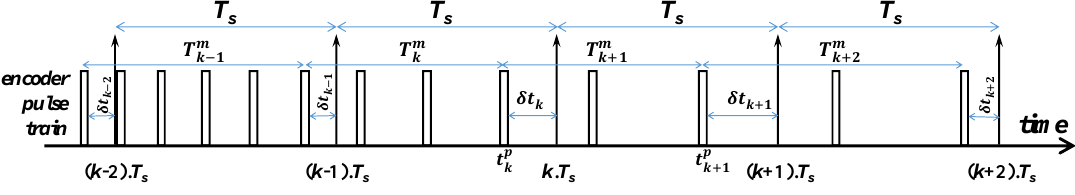
Figure 1. The timing diagram of encoder pulse train with sampling periods.